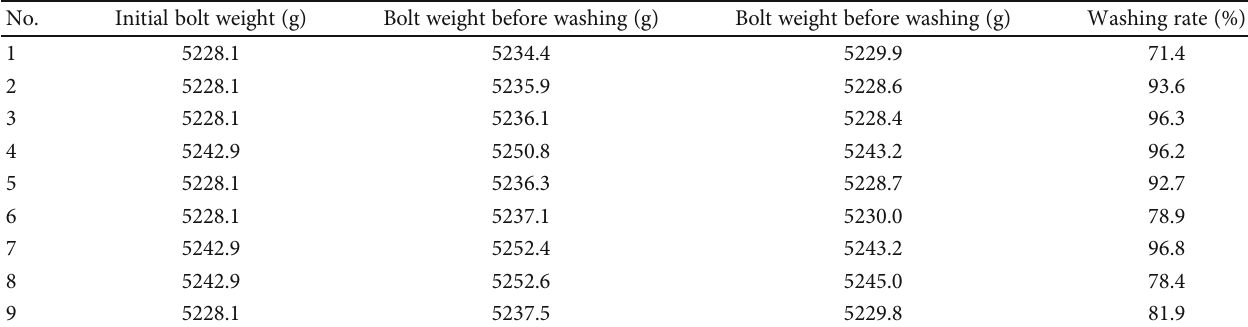
Table 4: Washing rate according to the orthogonal